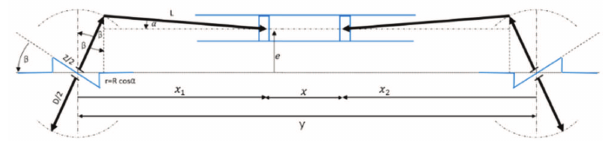
Fig. 7. BEOP engine scheme